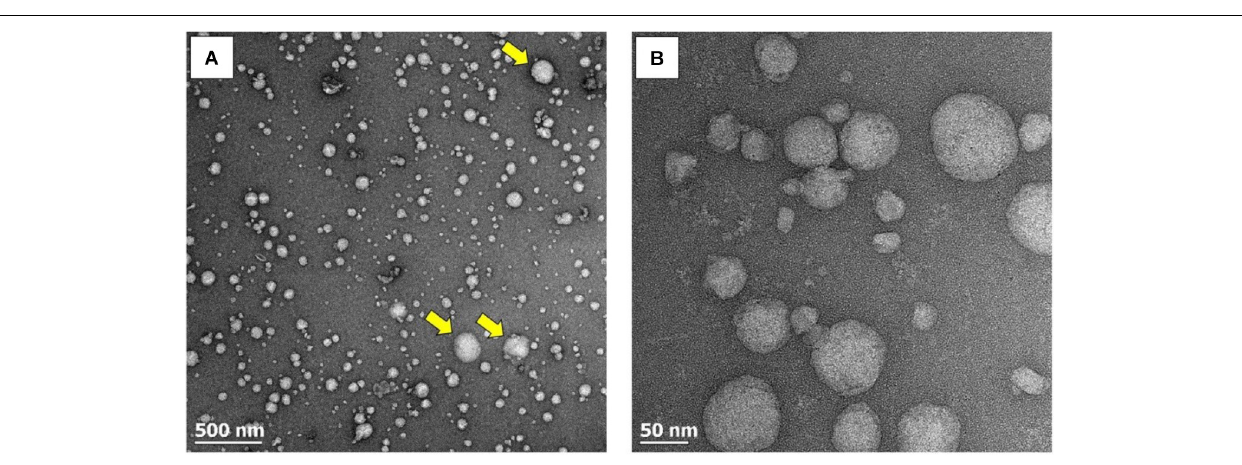
Frontiers in Physiology |